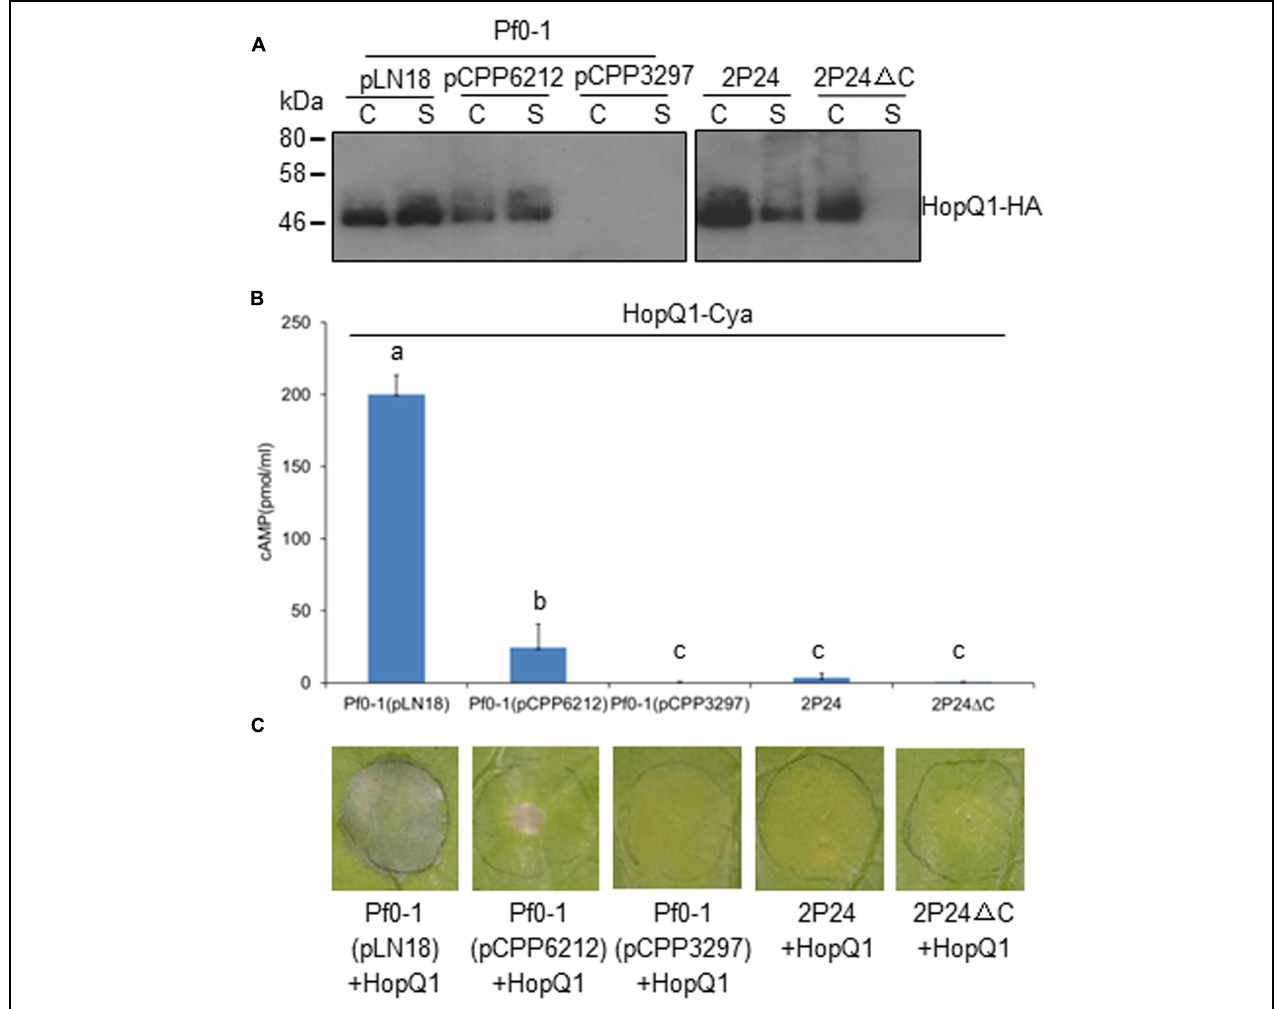
FIGURE 5 | P. fluorescens 2P24 has a T3SS-dependent secretion + /translocation − capacity. (A) HopQ1-HA secretion assay. Strains transformed with pCPP5372-hopQ1 were grown from an OD 600 of 0.3 to an OD 600 of 0.5. Cell pellet (C) and supernatant (S) fractions were separated by centrifugation. Fractions were analyzed by SDS-PAGE, followed by immunoblotting with anti-HA antibodies. (B) HopQ1-CyaA translocation into N. benthamiana . Strains transformed with pCPP5371-hopQ1 were infiltrated into panels of N. benthamiana leaves at 10 8 cfu/ml. 1.0 cm leaf disks were collected at 12 h post-inoculation. Effector translocation assays, based on cAMP production by the HopQ1-CyaA reporter, were performed in triplicate on disks from independent leaves. Means shown with the same letters are not different statistically at the 5% confidence level on the basis of Duncan’s multiple range test. (C) Strain 2P24 expressing HopQ1 in N. benthamiana does not elicit tissue collapse in accordance with the failure of translocation in 2P24. The bacteria carrying pCPP5372-hopQ1 were infiltrated as described above. Cell death was evaluated and representative leaves were photographed 48 h after inoculation. The experiment was repeated three times